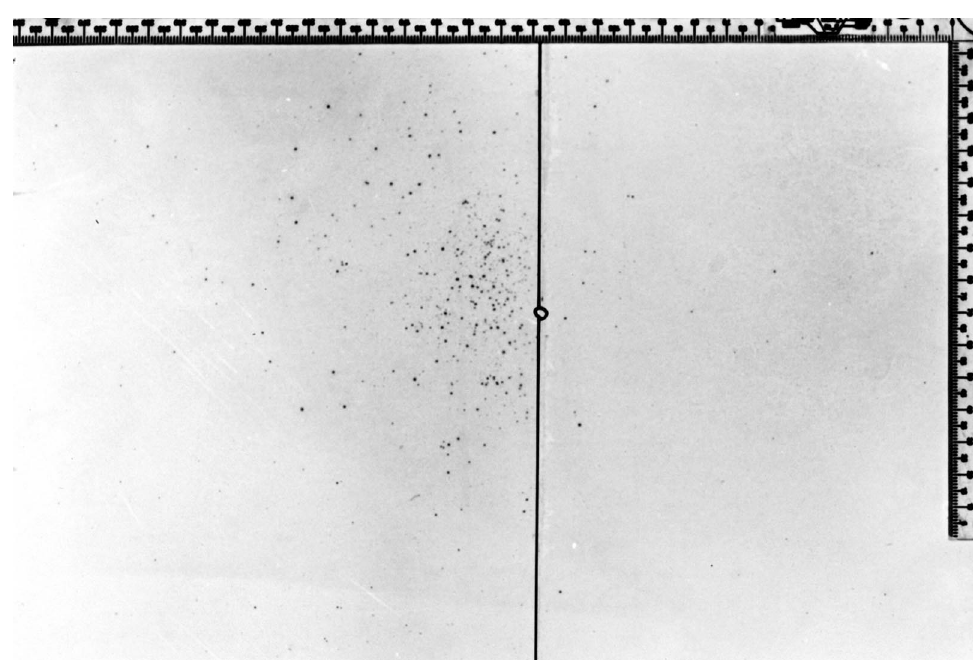
FIGURE 2 . The effect of machine washing on the total nitrite visualization on a white cotton cloth; ammunition 9-mm parabellum GFL FMJ, 25-cm shooting distance. Black and white photograph of the target: (left) the target without washing, (right) after washing. Persistence of GSR on